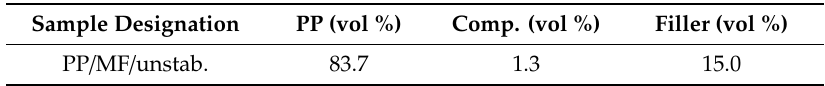
Table 1. Composition and designation of the compound, consisting of polypropylene (PP), the compatibilizer (Comp.), and the